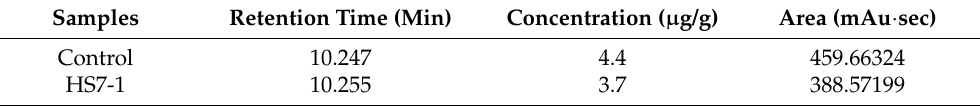
Table 1. HPLC statistics of the standard HupA and HS7-1 strain crude alkaloid extract.